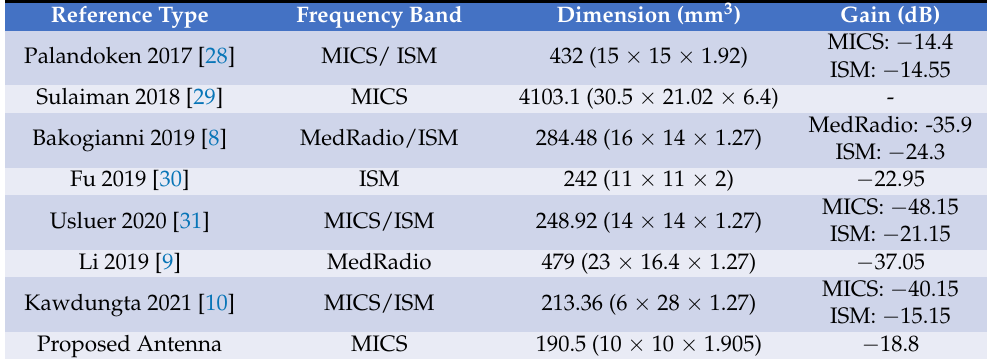
Table 2. Comparison of characteristics of implantable